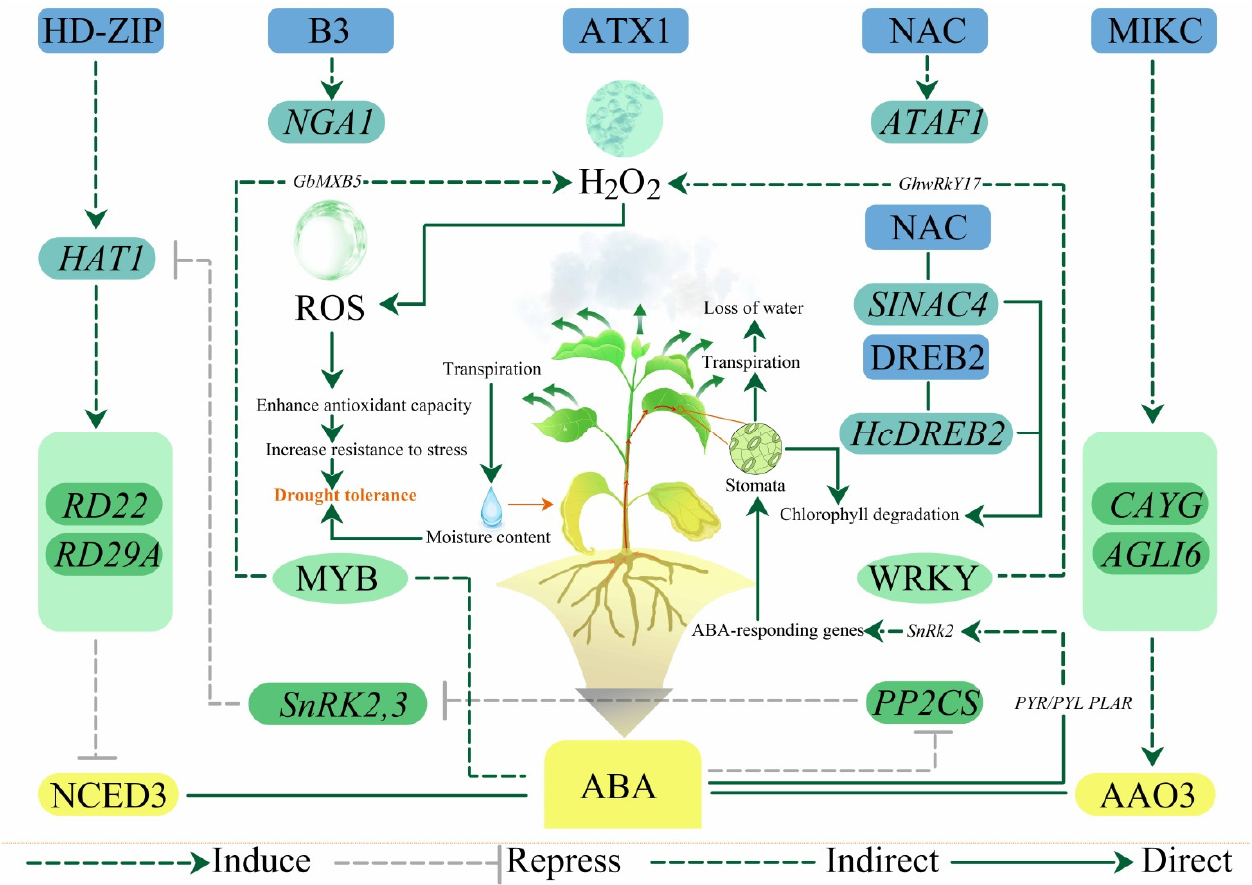
Figure 2. Regulatory mechanisms of abscisic acid (ABA) and related genes in response to drought stress in plants.